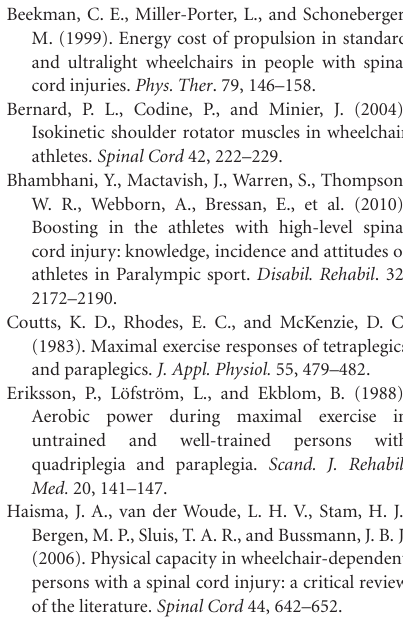
in the international para-cycling competi- tions. With the current system of scoring, paraplegic women are favored with regard to the tetraplegic men to be a TR member. In one concerns to the tetraplegic athletes disappearance, we therefore recommend to UCI a high caution in the choice of the race